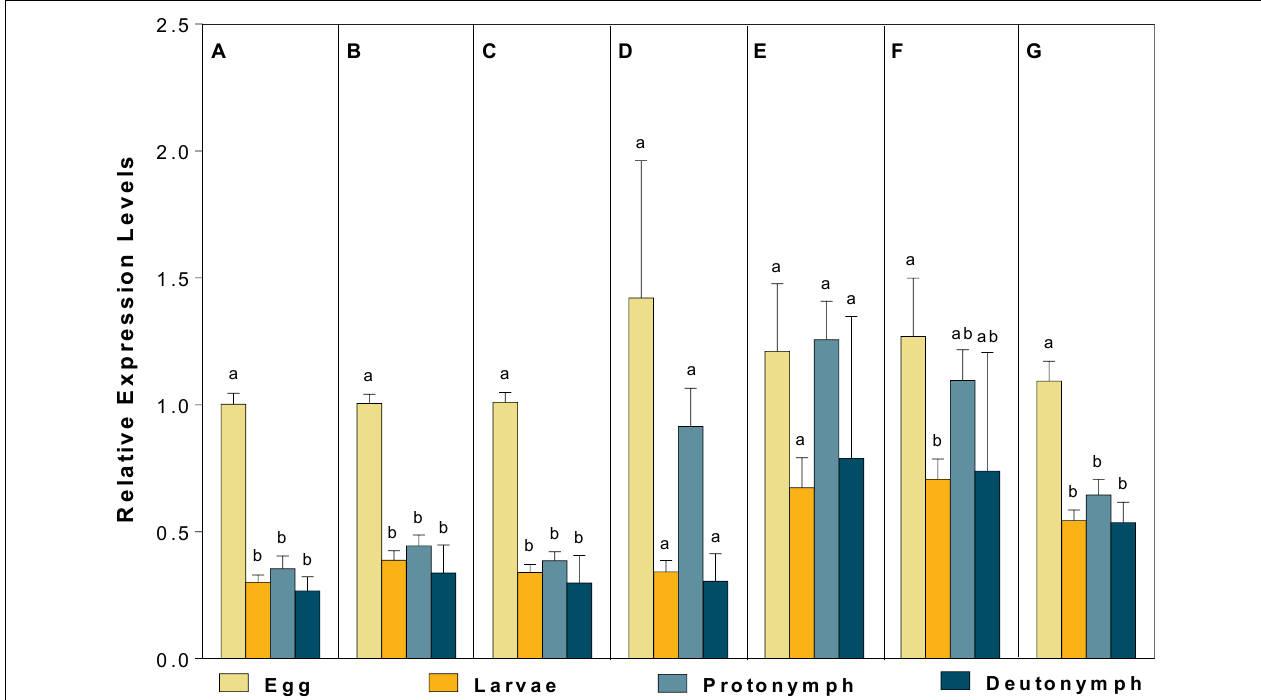
FIGURE 5 | Validation of the recommended reference genes. Expression profiles of CBP among different developmental stages were investigated using seven different normalization factors, including (A) the most suited ( V-ATPase ), (B) the top two most suited ( V-ATPase, Actin3 ), (C) the top three most suited ( V-ATPase, Actin3, GAPDH ), (D) the least suited ( 18S ), (E) the top two least suited ( 18S, RPL13 ), (F) the top three least suited ( 18S , RPL13 , RPS9 ), and (G) all the candidate reference genes. Bars represent the means ± standard error of six biological replications. Different letters indicate significant differences ( P < 0.05).